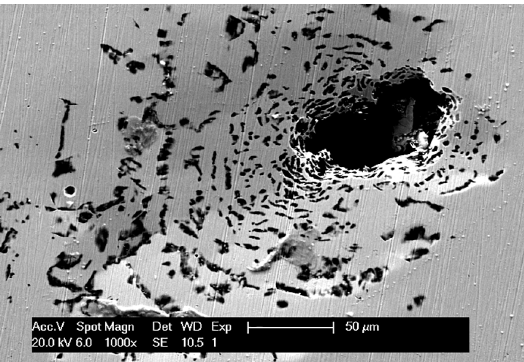
Figure 10. SEM image of a specific pit on the surface of the 316L steel after the cyclic polarization tests in CO medium.